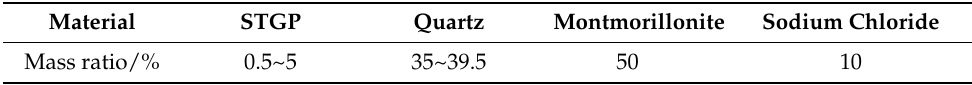
Table 4. Proportioning of similar